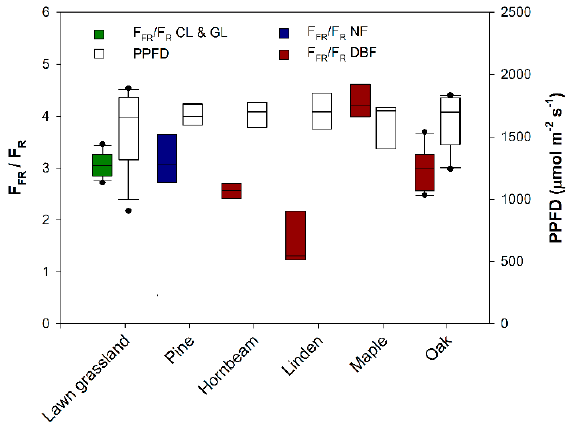
Figure 3. Plot of the median, 10th, 25th, 75th and 90th percentiles as vertical boxes of the ratio between F FR and F R estimated at canopy level (full bars). Empty bars refer to the incident photosynthetic photon flux density (PPFD) expressed in µmol·m − 2 ·s − 1 . The statistics refer to 20 samples for each species. CL: cropland, GL: grassland, NF: Needleleaf Forest, DBF: Deciduous Broadleaf Forest.